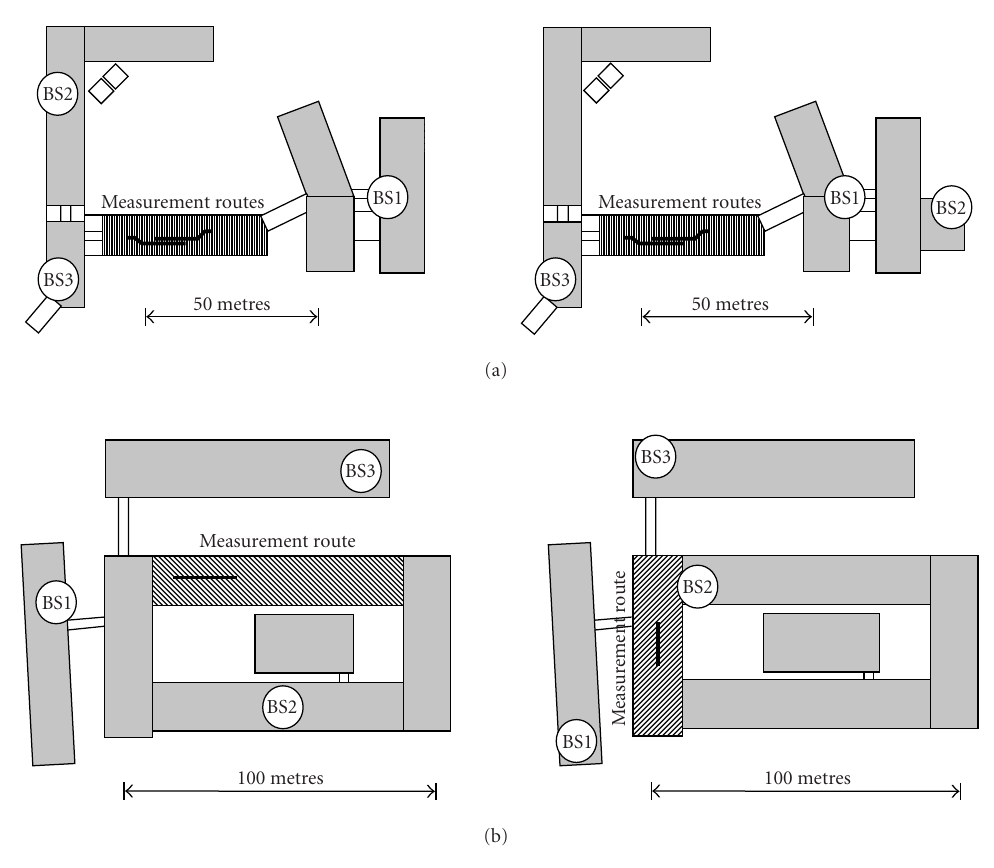
Figure 1: Measurement situations and BS configurations for the indoor campaign: (a) star configuration for the new building (left) and inline configuration for the new building (right); (b) star configuration for the old building (left) and inline configuration for the old building (right). The new buildings’ first route is to the right, walked from left to right, while the second route is to the left, walked from right to